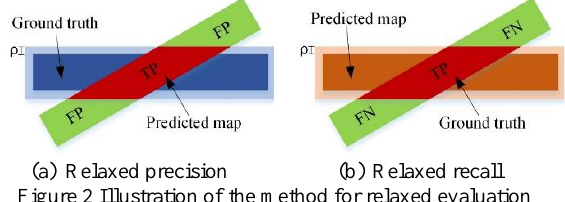
Figure 2 Illustration of the method for relaxed evaluation